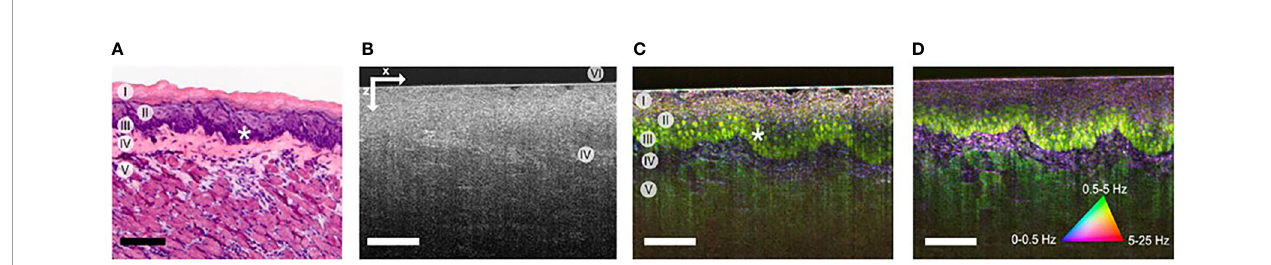
FIGURE 7 | (A) HE stained histology of the imaged sample at different location (I) corni fi ed layer, (II) granular & spinous layers, (III) basal layers, (IV) lamina propria, (V) muscle, and (VI) glass plate. (B) OCT image of mouse tongue; lamin propira (IV) can be identi fi ed by brighter contrast. (C) Corresponding dynamic contrast mOCT image with a focus in basal layer (I-V) and even nuclei (*) are visible. (D) Dynamic contrast m OCT image with a focus in the lamina propria; the image size is 380x500 m m (zx); scale bar, 100 m m [from